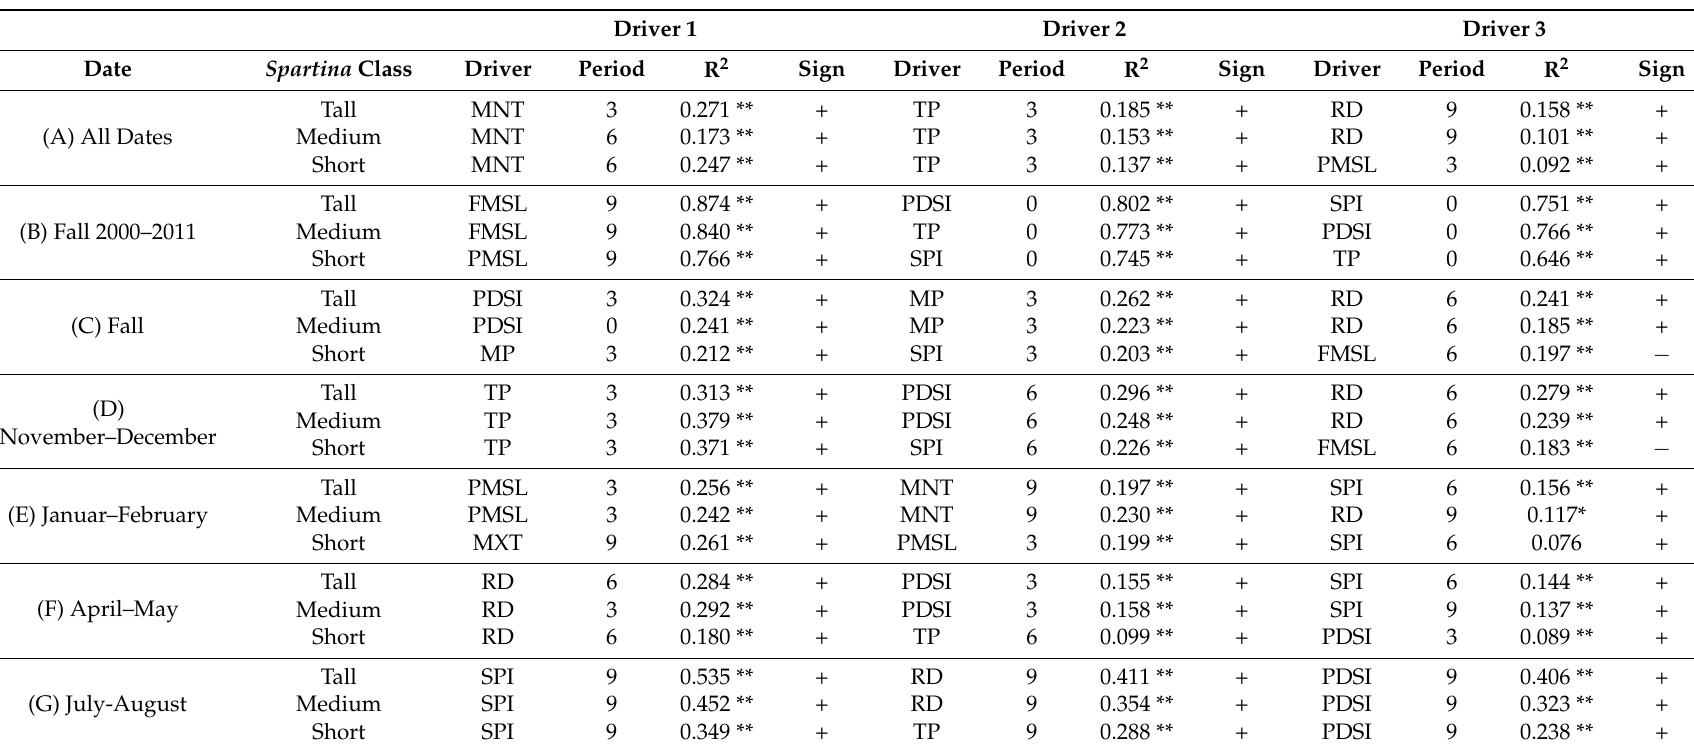
Table A2. Top three abiotic drivers best predicting S. alterniflora biomass across each height class for (A) all dates ( n = 294) from 1984 to 2011, (B) all dates falling between the last week of September through the first week of November ( n = 10) from 2000 to 2011; and all dates 1984–2011 (C) within the last week of September through the first week of November ( n = 39), (D) within November and December ( n = 52), (E) with in January and February ( n = 49), (F) within April and May ( n = 69), and (F) within July and August ( n = 33). Period = month running mean, * = p < 0.05, ** = p < 0.01, Sign = sign of regression